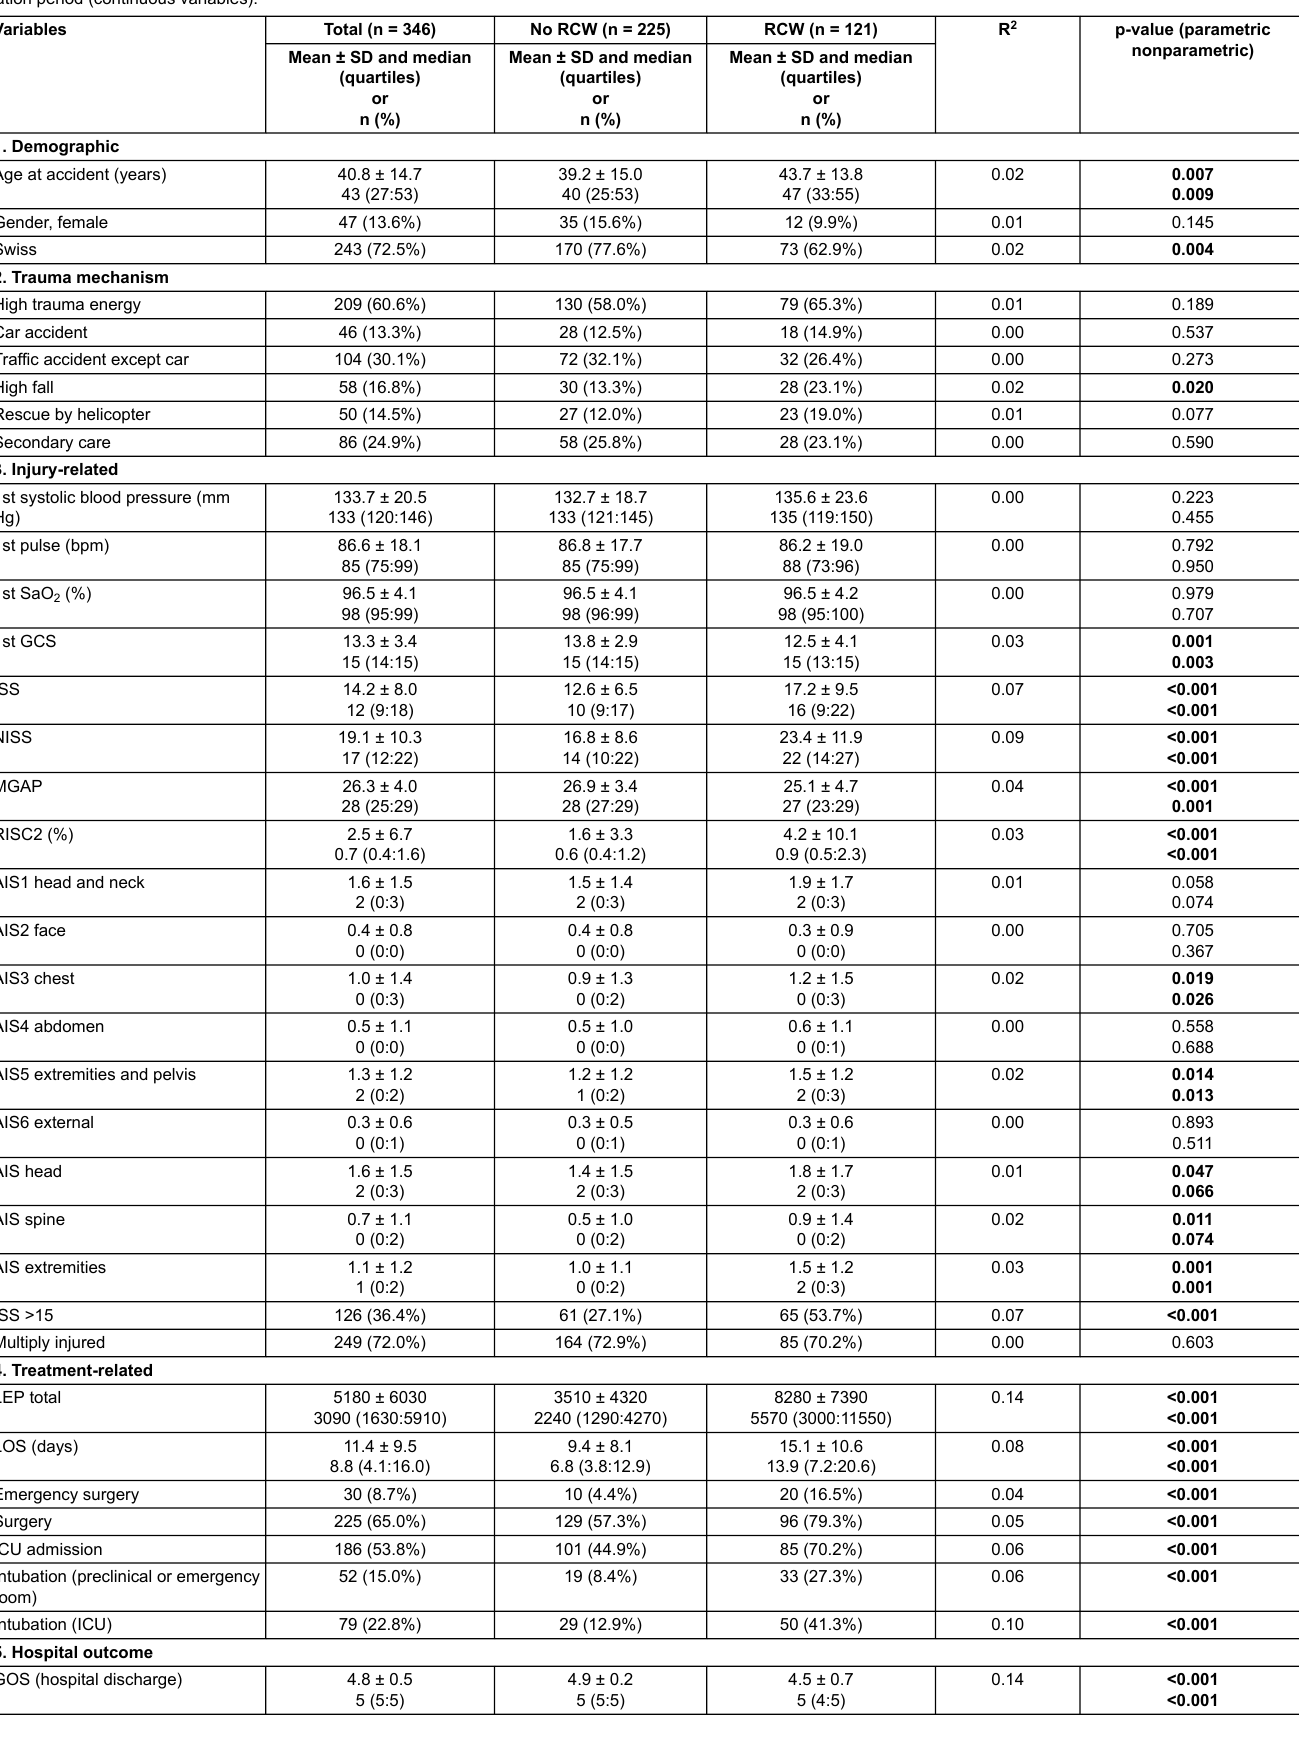
Table 1: Descriptive data for survivors of trauma (n = 346) grouped according to reduced capacity for work (RCW yes/no) experienced at least once during the four year obser- vation period (continuous variables). Variables Total (n =